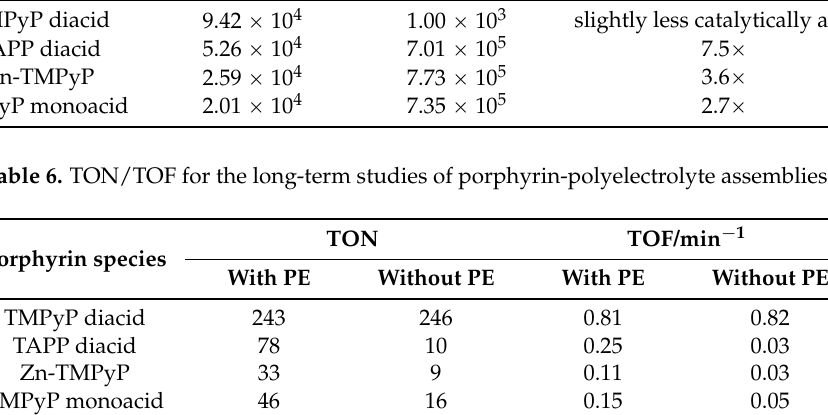
Figure 6. ( Left ) Image of samples after 2 h of irradiation with visible light. The increased catalytic activity can be seen by eye. Samples with polyelectrolyte (2, 4, 6, 8) are intensively yellow-colored. 1, 2: TMPyP diacid; 3, 4: TAPP diacid; 5, 6: Zn-TMPyP; 7, 8: TMPyP monoacid; ( Right ) kinetics of triiodide formation: extinction coefficient ε at λ = 353 nm versus irradiation time (5 h) for different porphyrin-PSS brush assemblies in acidic aqueous iodide solution. Table 5. Generated concentrations of triiodide (mol/L) after 5 h of irradiation. Porphyrin species With PE Without PE Increased activity with PE